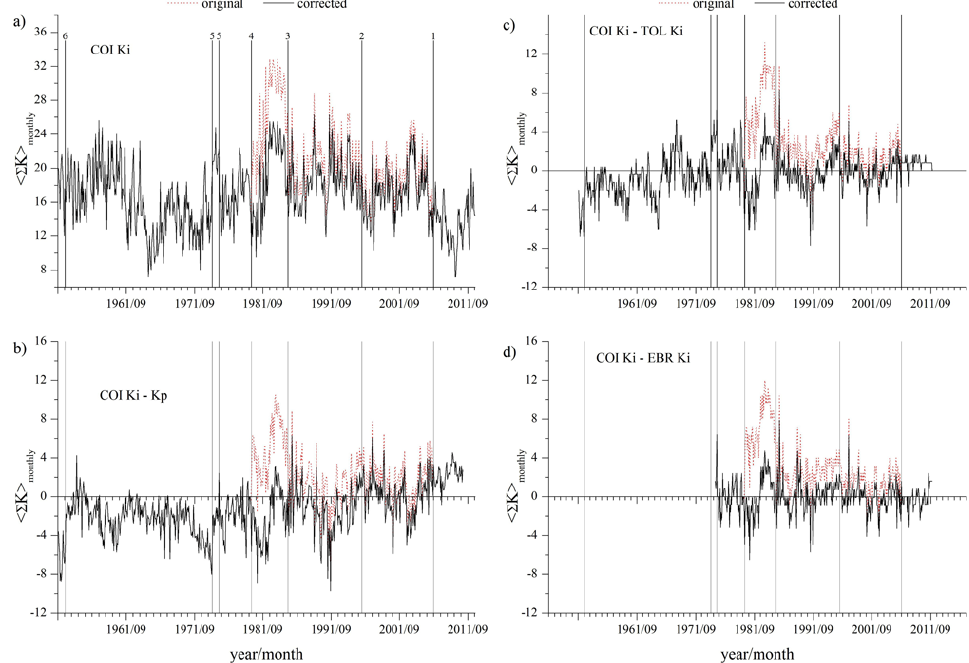
Fig. 3. Original (red dashed lines) and corrected (black solid lines) series for COI Ki (a) , and for differences between COI Ki and reference series: Kp (b) , TOL Ki (c) and EBR Ki (d) . Vertical lines mark the dates of the breaks (see Table